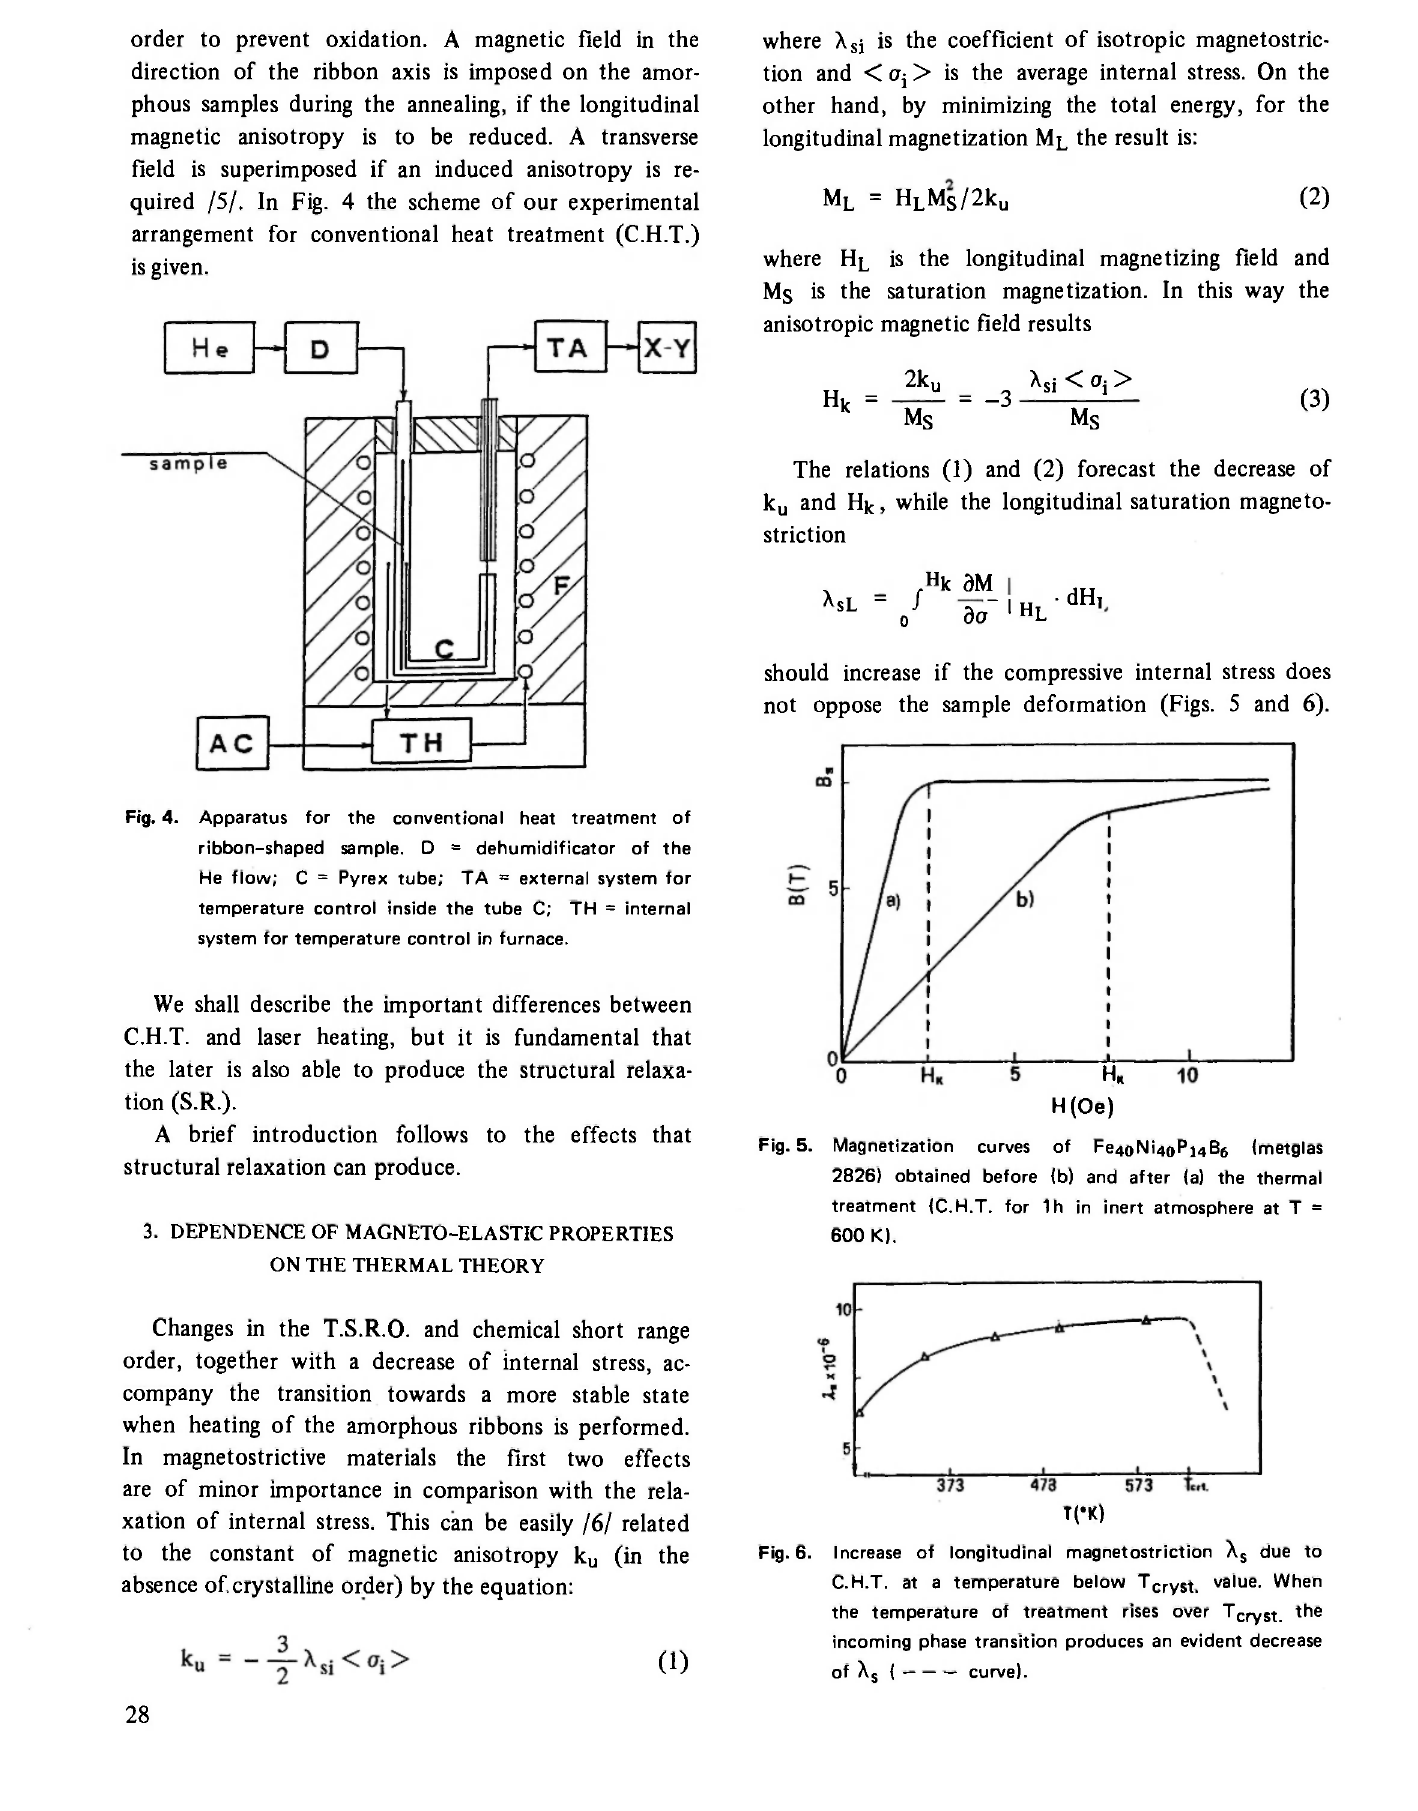
Fig. 6. Increase of longitudinal magnetostriction X s due to C.H.T. at a temperature below T cr y St value. When the temperature of treatment rises over T cr y St the